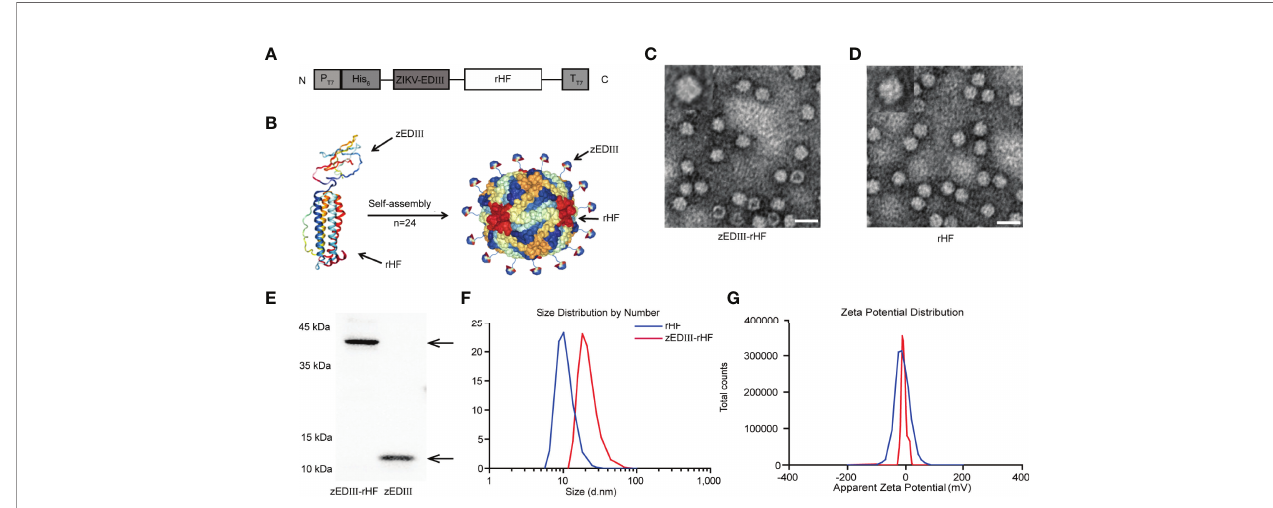
FIGURE 1 | Construction and characterization of zEDIII-rHF nanoparticles. (A) Design of the zEDIII-rHF fusion protein: E protein domain III (zEDIII) was linked to the N-terminus of the human ferritin heavy chain (rHF). (B) 3D schematic diagram of zEDIII-rHF nanoparticles. (C) TEM image of zEDIII-rHF cages, bar=20 nm. (D) TEM image of rHF cages, bar=20 nm. (E) Western blot analysis of zEDIII and zEDIII-rHF. (F) Size distribution analysis of zEDIII-rHF nanoparticles via DLS showing an average diameter of 18.07 nm, which was larger than the diameter of rHF cages (mean = 12.92 nm). (G) Zeta potential distribution diagram for the cages. The average zeta potentials of zEDIII-rHF and rHF cages in assembly buffer were -15.27 ± 1.20 mV and -19.83 ± 1.07 mV,